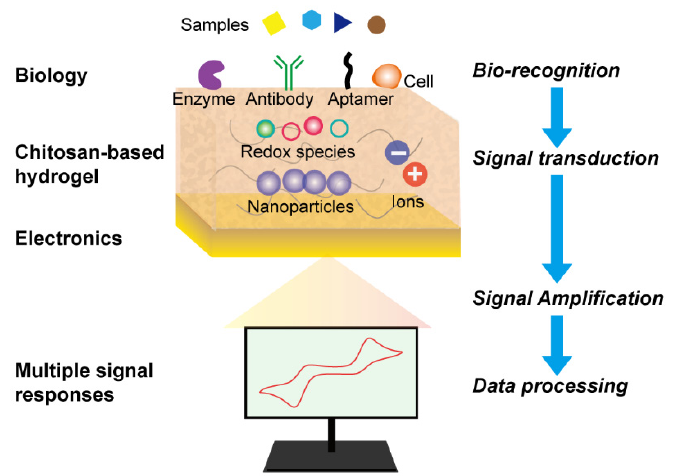
Figure 1. Schematic illustration of chitosan ‐ based bioelectronic